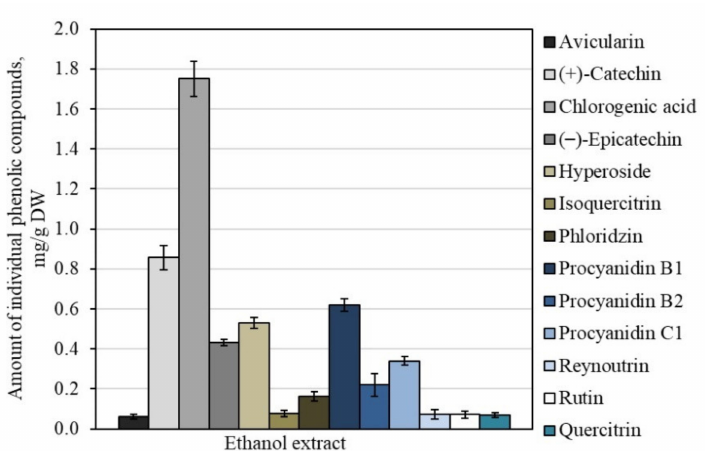
Figure 4. Variation in the quantitative amount of phenolic compounds in the dry extracts of whole